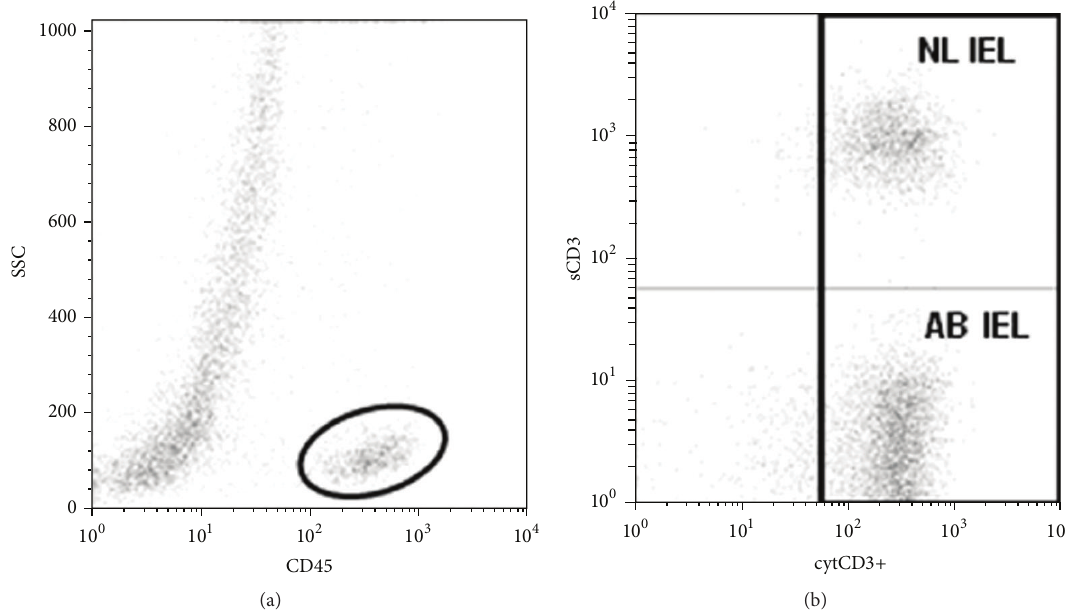
Figure2:FlowcytometricanalysistoidentifyaberrantandnormalIELs.CellswithastrongCD45expressionandlowtointermediateforward and sideward scatter were selected (a), after which IELs expressing intracellular CD3 expression were used for further studies (b). Ab IEL: aberrant IEL population (sCD3-cytCD3+): NL IEL: normal IEL population (sCD3 +